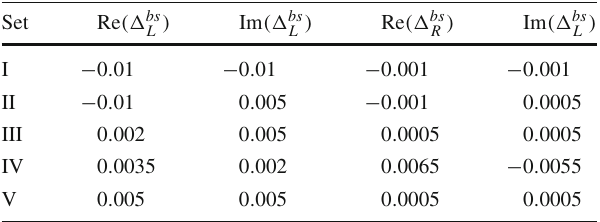
Table3 Samplesetsoftheparameterspaceat M Z (cid:3) = 1TeVthatsatisfy both (cid:5) M B and S ψφ s